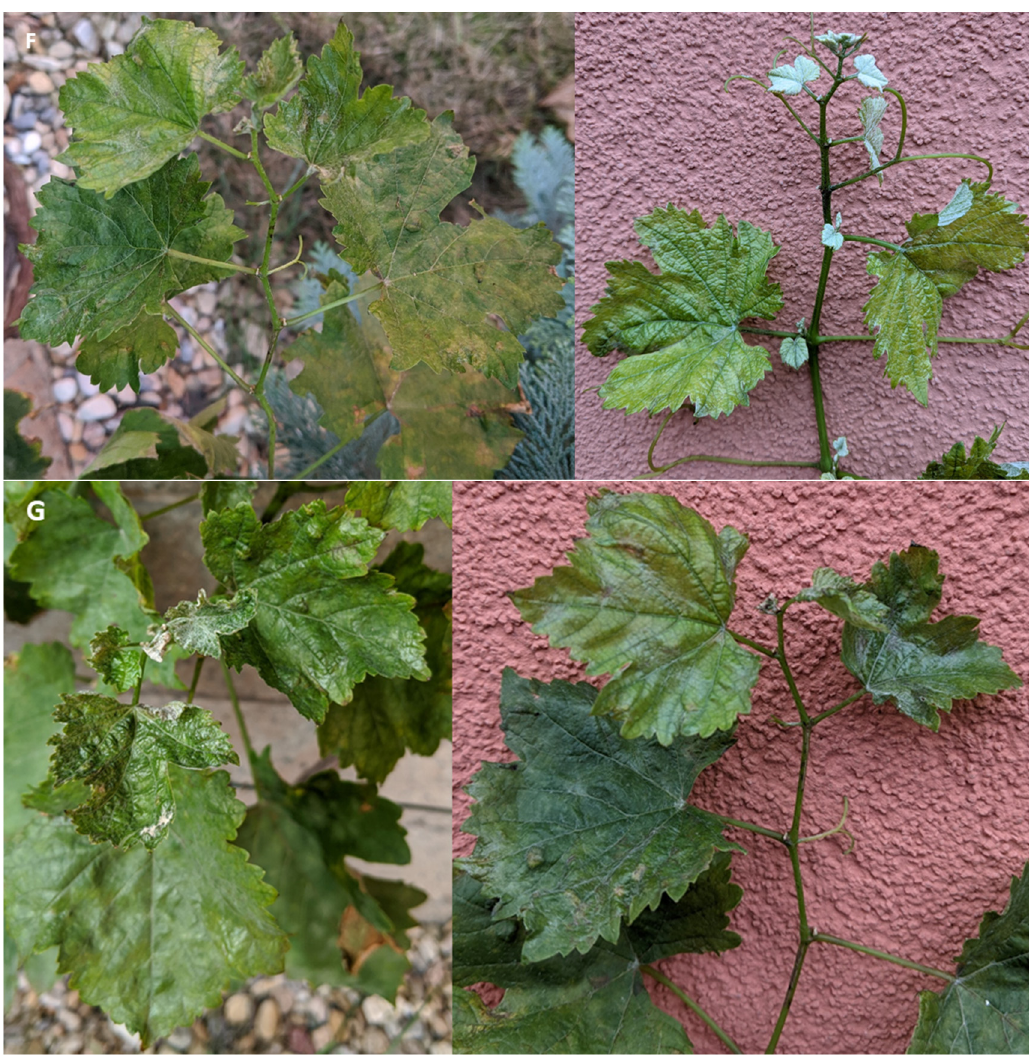
Figure 1. The symptoms observed on seven surveyed grapevines. The pictures were taken at the same time in case of each grapevine; ( A ) grapevine Sb/SO4_1 showed yellowing of the leaves and a distinctive chlorosis appeared on the leaves; ( B ) Sb/SO4_2 showed curly top leaves, deformation of the leaves, stunted growth, thin internodes, and dense foliage; ( C ) Sb/SO4_3 similarly as Sb/SO4_2 showed a strong inhibition of growth showed by stunted deformed leaves and shortened and thin internodes, curly top leaves and dense foliage; ( D ) Sb/SO4_4 top leaves were curly and deformed, also lateral shoots were highly inhibited in their growth, the leaves on shoots were infrequently distributed; ( E ) Sb/SO4_6 compared to the previous grapevines, this grapevine showed a highly dense foliage where the lateral leaves were highly stunted, internodes were shortened and the zig-zag internodes were evidenced; ( F ) Sb/SO4_7 curly top leaves, the leaves and shoots were clearly young comparing to the other observed grapevines; and, ( G ) Sb/SO4_8 curly top leaves, deformation of the leaves, stunted growth, and thin internodes, the leaves on shoots were infrequently distributed with no lateral shoots. The top leaves were deformed.